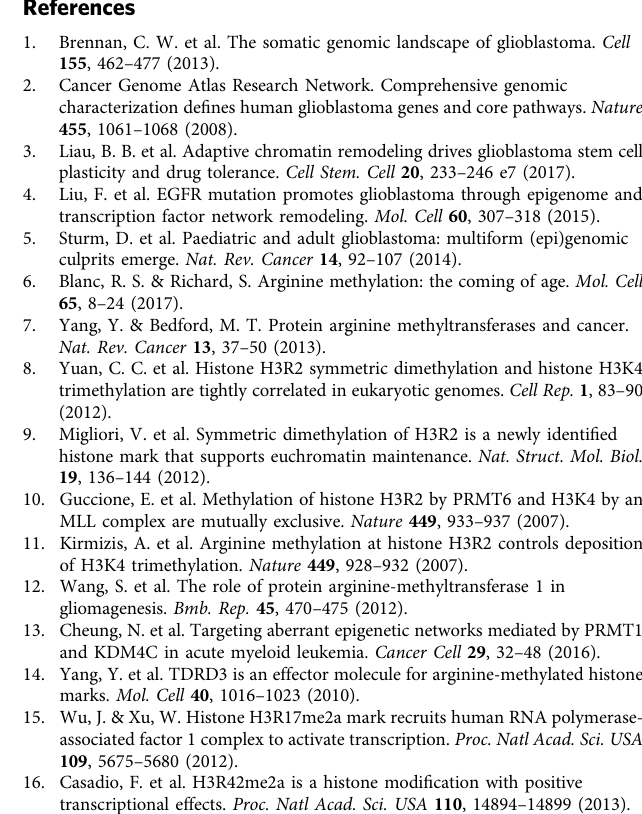
Fig. 7 PRMT2 methyltransferase activity is required for GBM cell growth and tumorigenesis. a Correlation between H3R8me2a levels and tumor grades. Tumor sections from 21 glioma specimens were IHC-stained with anti-H3R8me2a antibody. Lines within boxes indicate medians of the scores. b Correlation between H3R8me2a levels and Ki67 density in 21 GBM specimens. Representative examples of H3R8me2a and Ki67 immunostainings are shown in different grade of glioma specimens; scale bar, 200 µ m (left panel). Stainings of nuclear H3R8me2a and Ki67 were scored and the signi fi cance